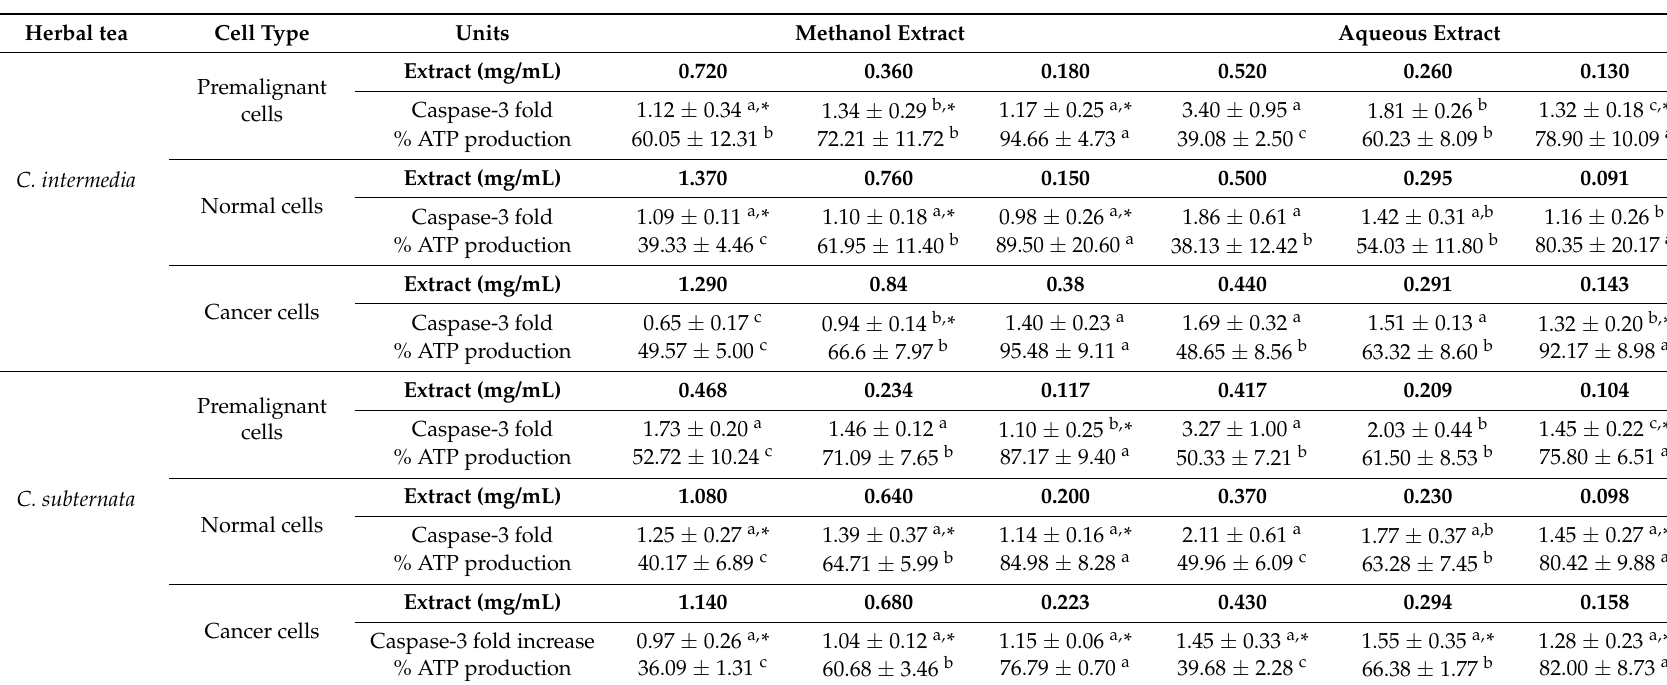
Table 3. Dose response effects of methanol and aqueous extracts of C. intermedia and C. subternata (honeybush) on the pro-apoptotic activity as a function of cell viability (ATP production) in skin